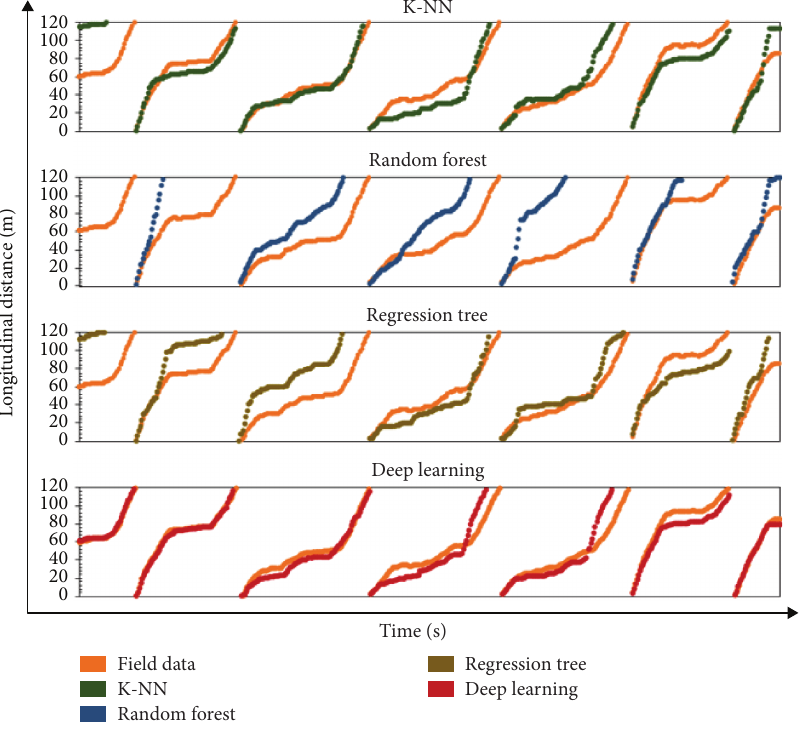
Figure 7: Time-space plots of the vehicles. Table 5: Comparison of MAPE (%) in vehicle positions among the algorithms at the microscopic